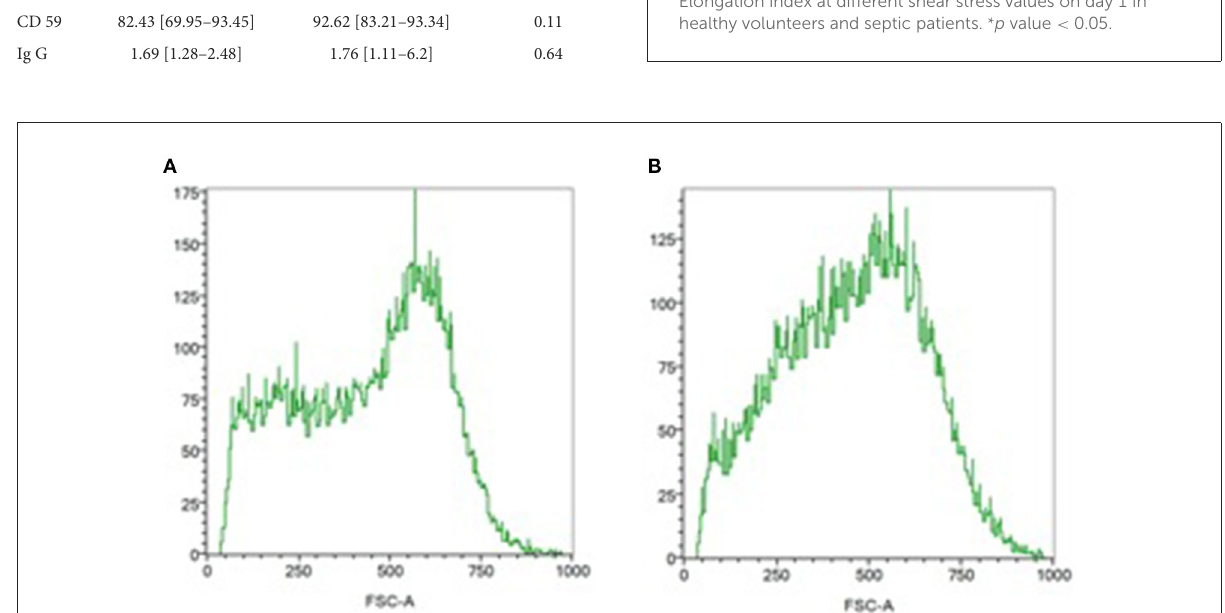
FIGURE1 Assessment of the RBC shape by flow cytometry. RBC distribution histograms relating number of events and forward light scatter (FSC) distribution (size estimation). (A) In normal biconcave, ellipsoid red blood cells, the FSC distribution (size estimation) is bimodal. (B) Monomodal distribution is observed in septic patient, suggesting a more spherical